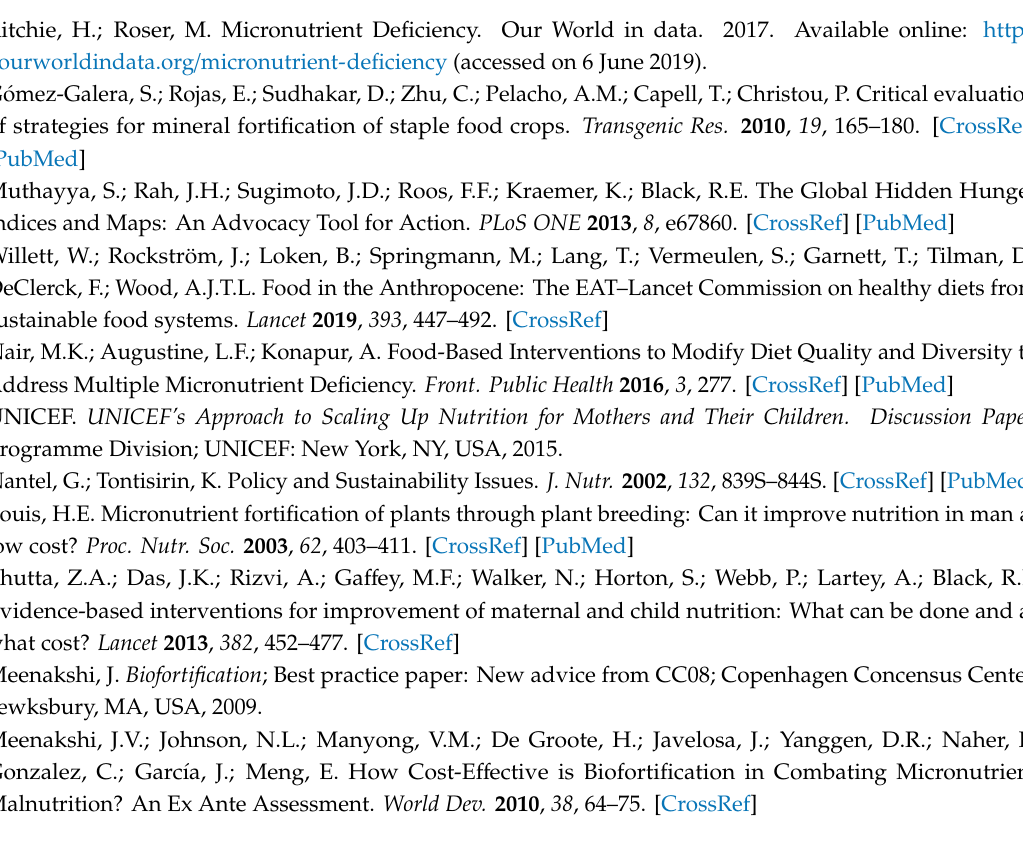
Figure S1: Summary of number of voluntary and mandatory fortification programs in di ff erent parts of the world, Figure S2: Summary of number of voluntary and mandatory fortification programs for the various food vehicles, Table S1: High income and upper middle income countries by regulation type, food vehicle and household coverage / proportion industrially processed, Table S2: Lower middle income by regulation type, food vehicle and household coverage / proportion industrially processed, Table S3: Low income countries by regulation type, food vehicle and household coverage / proportion industrially processed, Table S4: Review of key knowledge gaps / policies / business models by vehicle / region and scale, Table S5: Biofortification review of key knowledge gaps / policies / business